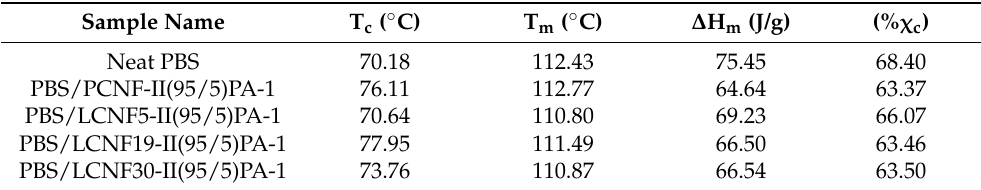
Figure 8. DSC graph of neat PBS, PBS/PCNF, and PBS/LCNF with different lignin content on heating ( a ) and cooling ( b ) cycles. Table 5. Crystallization temperature (T c ), melting temperature (T m ), melting enthalpy ( ∆ H m ), and % crystallinity (% χ c ) of neat PBS, PBS/PCNF, and PBS/LCNF with different lignin content at a ratio of